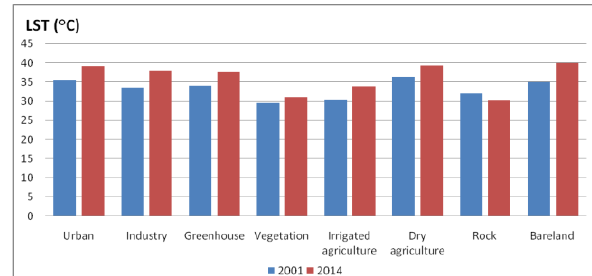
Figure 6. Graph of the LU/LC types and their LST